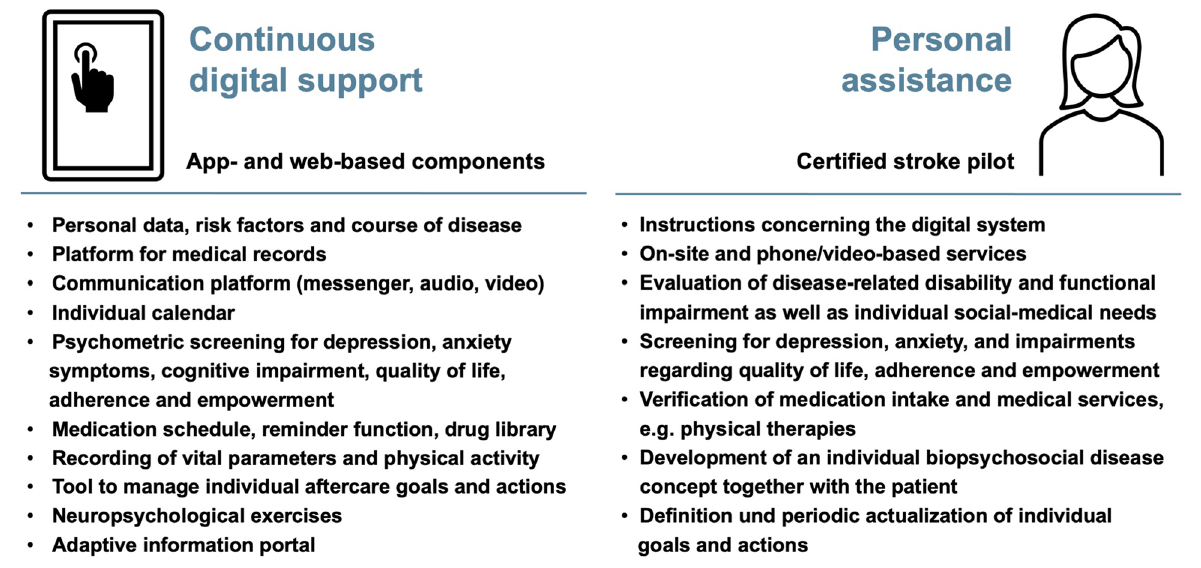
Fig. 1 Overview of the PostStroke-Manager concept with combined digital support and personal assistance. Using a tablet with a pre-installed app, 10 components will be available for the patient that cover different aspects of post stroke management. Personal assistance will be given by a nurse with special training in case management and typical issues arising in acute and later stages of stroke. The figure including icons was created with Microsoft PowerPoint and Word for Mac (version 16.47, 2021, Microsoft, Redmond,